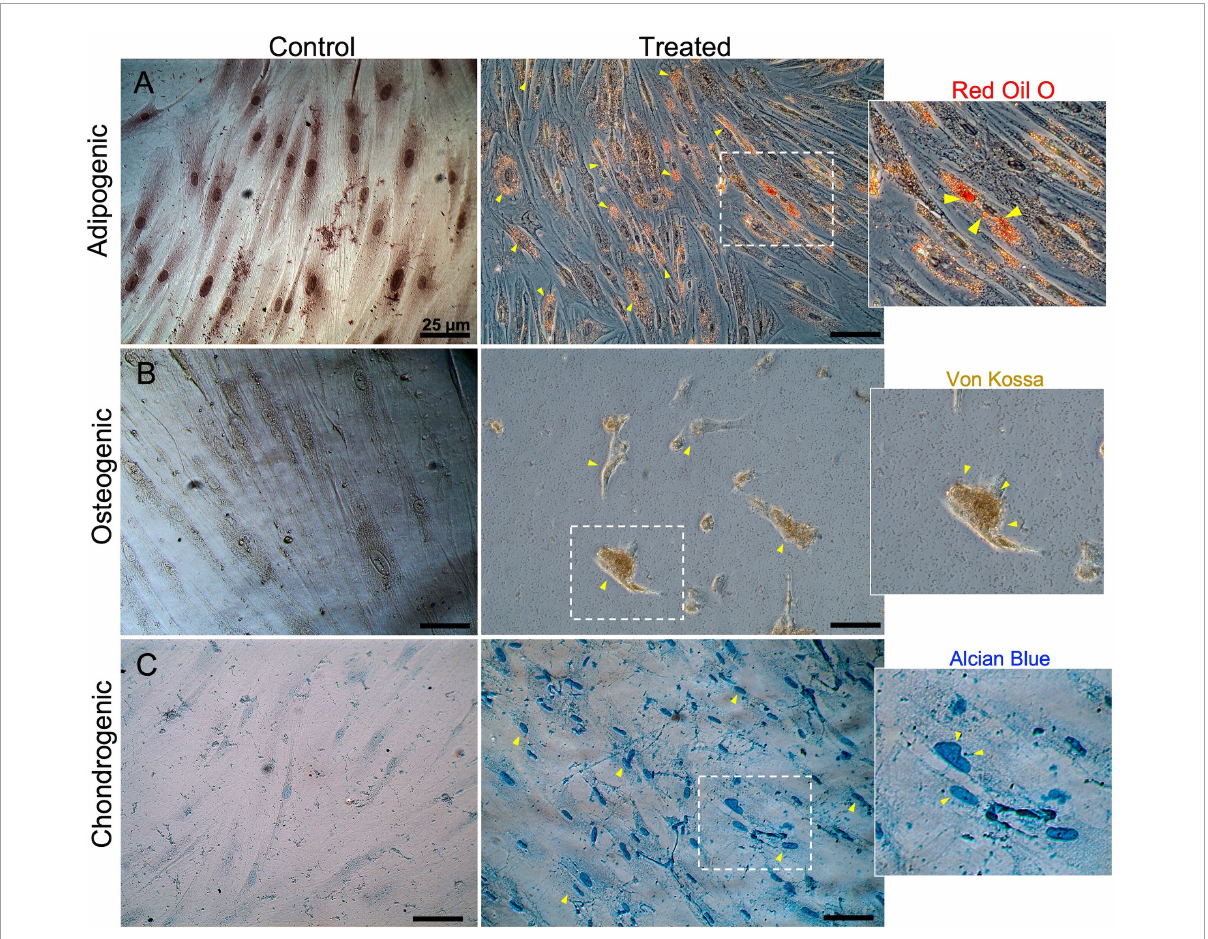
FIGURE2 Characterization by multi-differentiation potential in human mesenchymal stem cells (hMSCs). hMSCs were differentiated into adipocytes, osteocytes, and chondrocytes. (A) Adipogenesis was confirmed by the presence of lipid droplets stained with Oil Red O. (B) Osteogenesis was confirmed with positive Von Kossa staining of osteoblast calcium deposits. (C) Chondrogenesis was indicated by the staining of collagen fibers with alcian